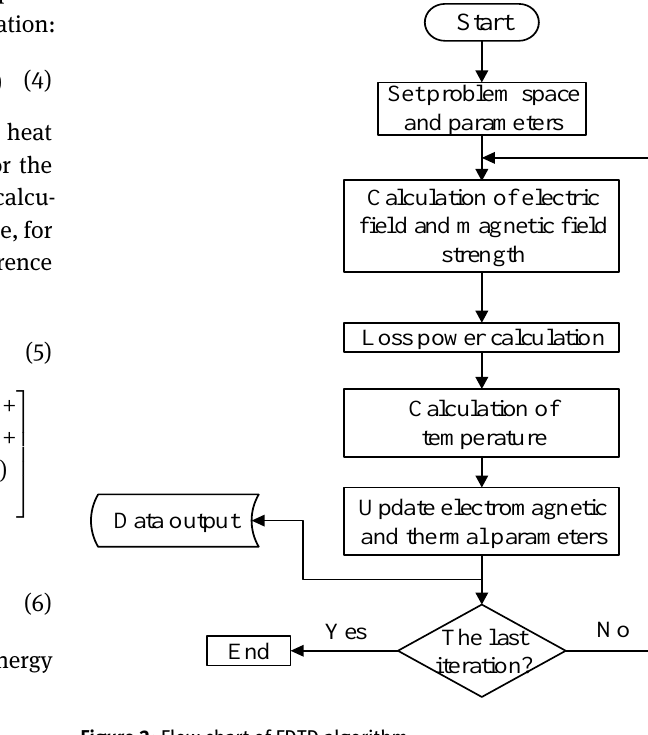
Figure 2: Flow chart of FDTD